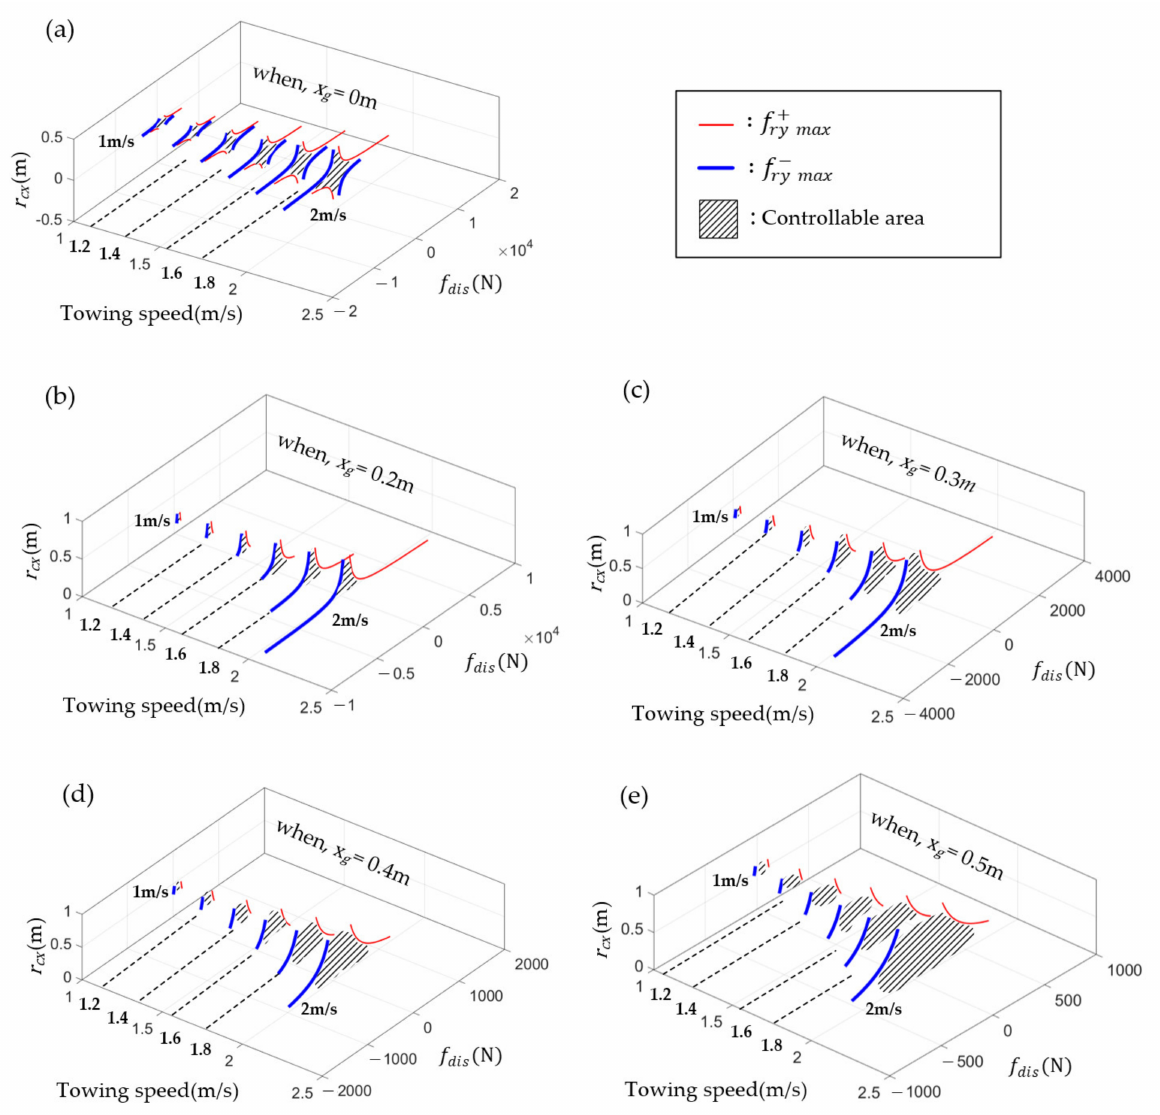
Figure 10. Allowable range of disturbance for yaw control when ( a ) x g = 0 m, ( b ) x g = 0.2 m, ( c ) x g = 0.3 m, ( d ) x g = 0.4 m, and ( e ) x g = 0.5